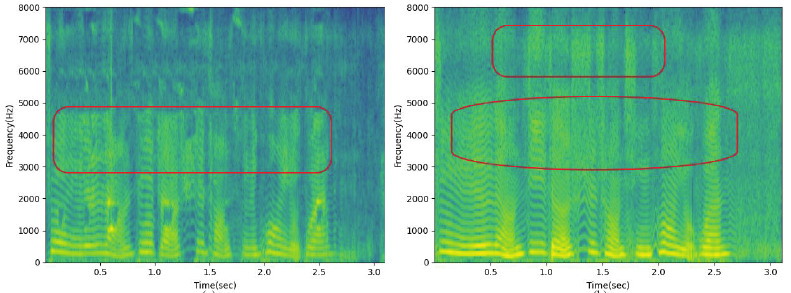
Figure 5. ( a ) AC speech spectrogram. ( b ) BC speech spectrogram.